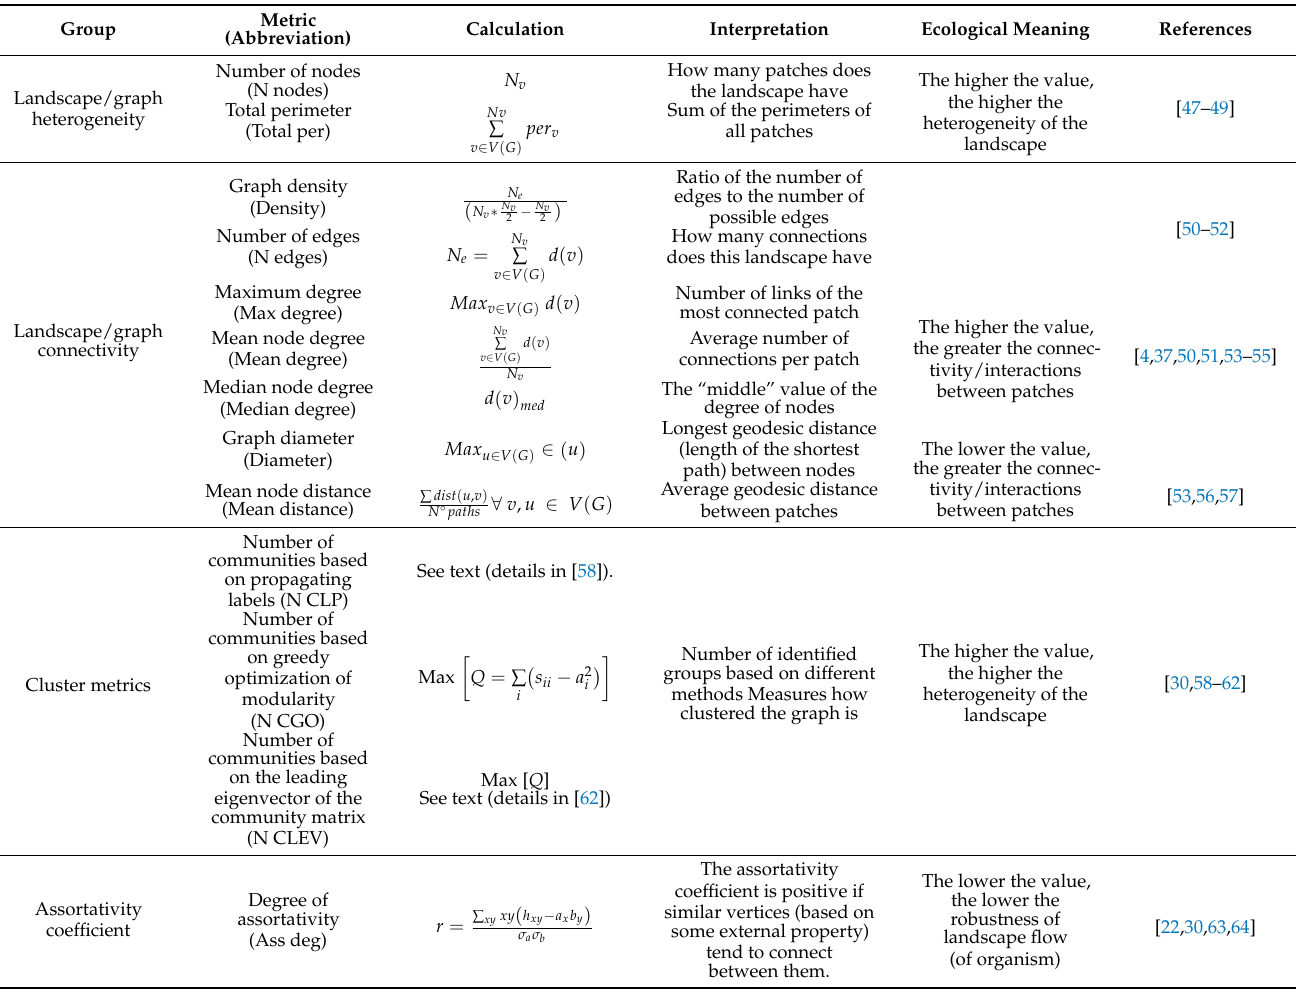
Table 1. Graph metrics selected to describe heterogeneity, connectivity, clustering, and assortativity at the landscape